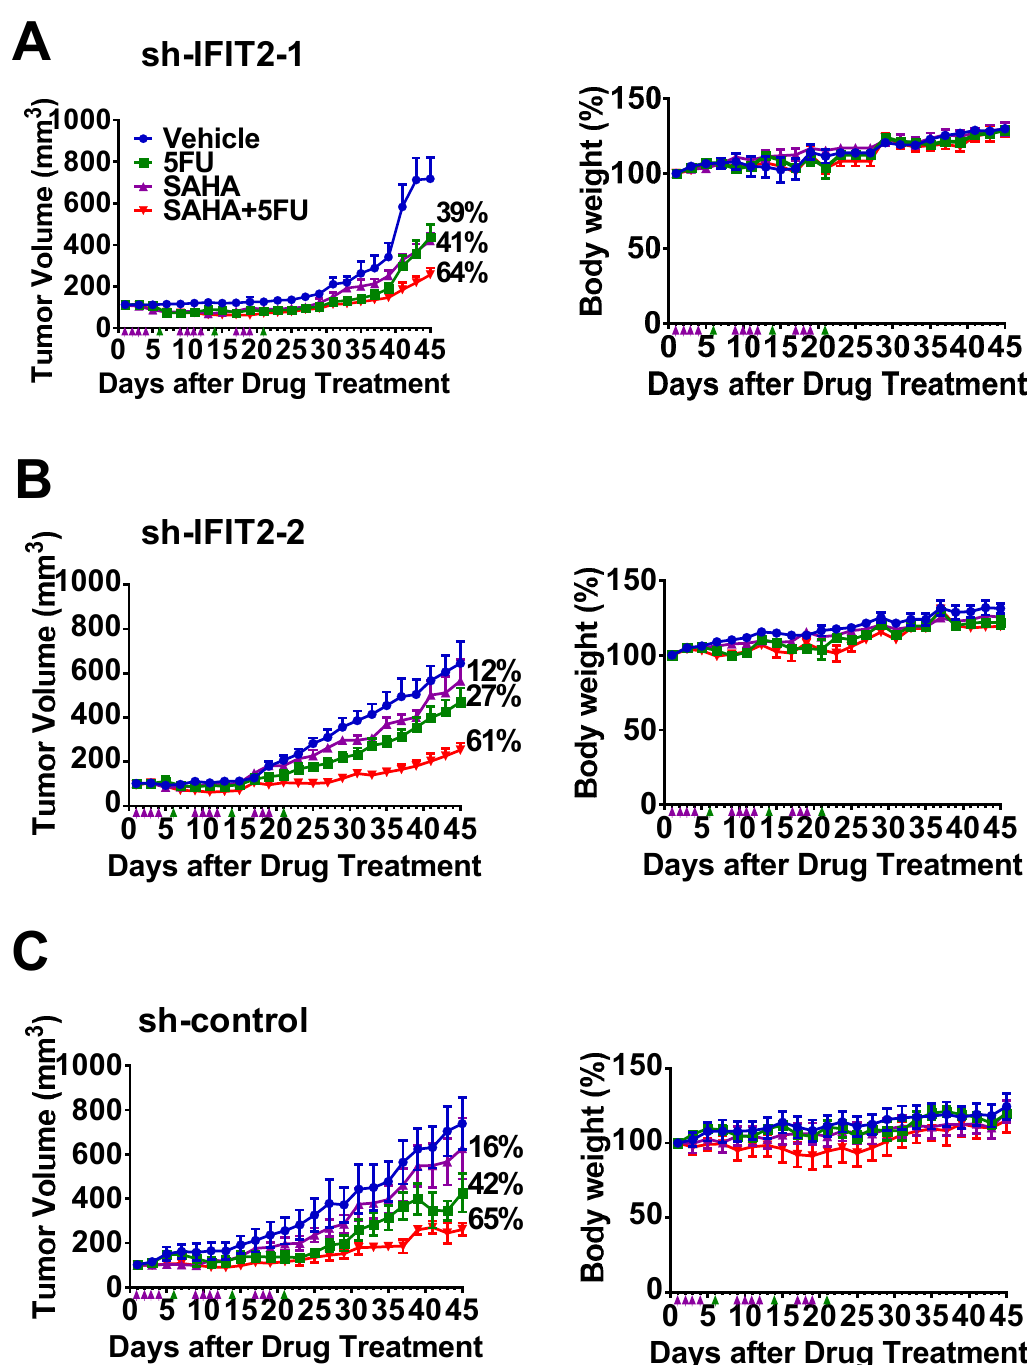
Figure 7. Synergistic inhibition of SAHA and 5-FU in a xenograft tumor model. ( A – C ) An aliquot of 10 7 cells (sh-IFIT2-1, sh-IFIT2-2 and sh-control) was subcutaneously implanted into nude mice. When the tumor reached approximately 100 mm 3 , the mice were randomly divided into four groups ( n = 4–5 for each group) and treated with vehicle ( ● ), SAHA ( ▲ , 80 mg/kg orally), 5-FU ( ▲ , 100 m/kg i.p.) or a combination of the two drugs ( (cid:72) ). The tumor volume (left) and body weight change (right) of the mice were recorded every other day. The values are shown as the mean ± SD of each